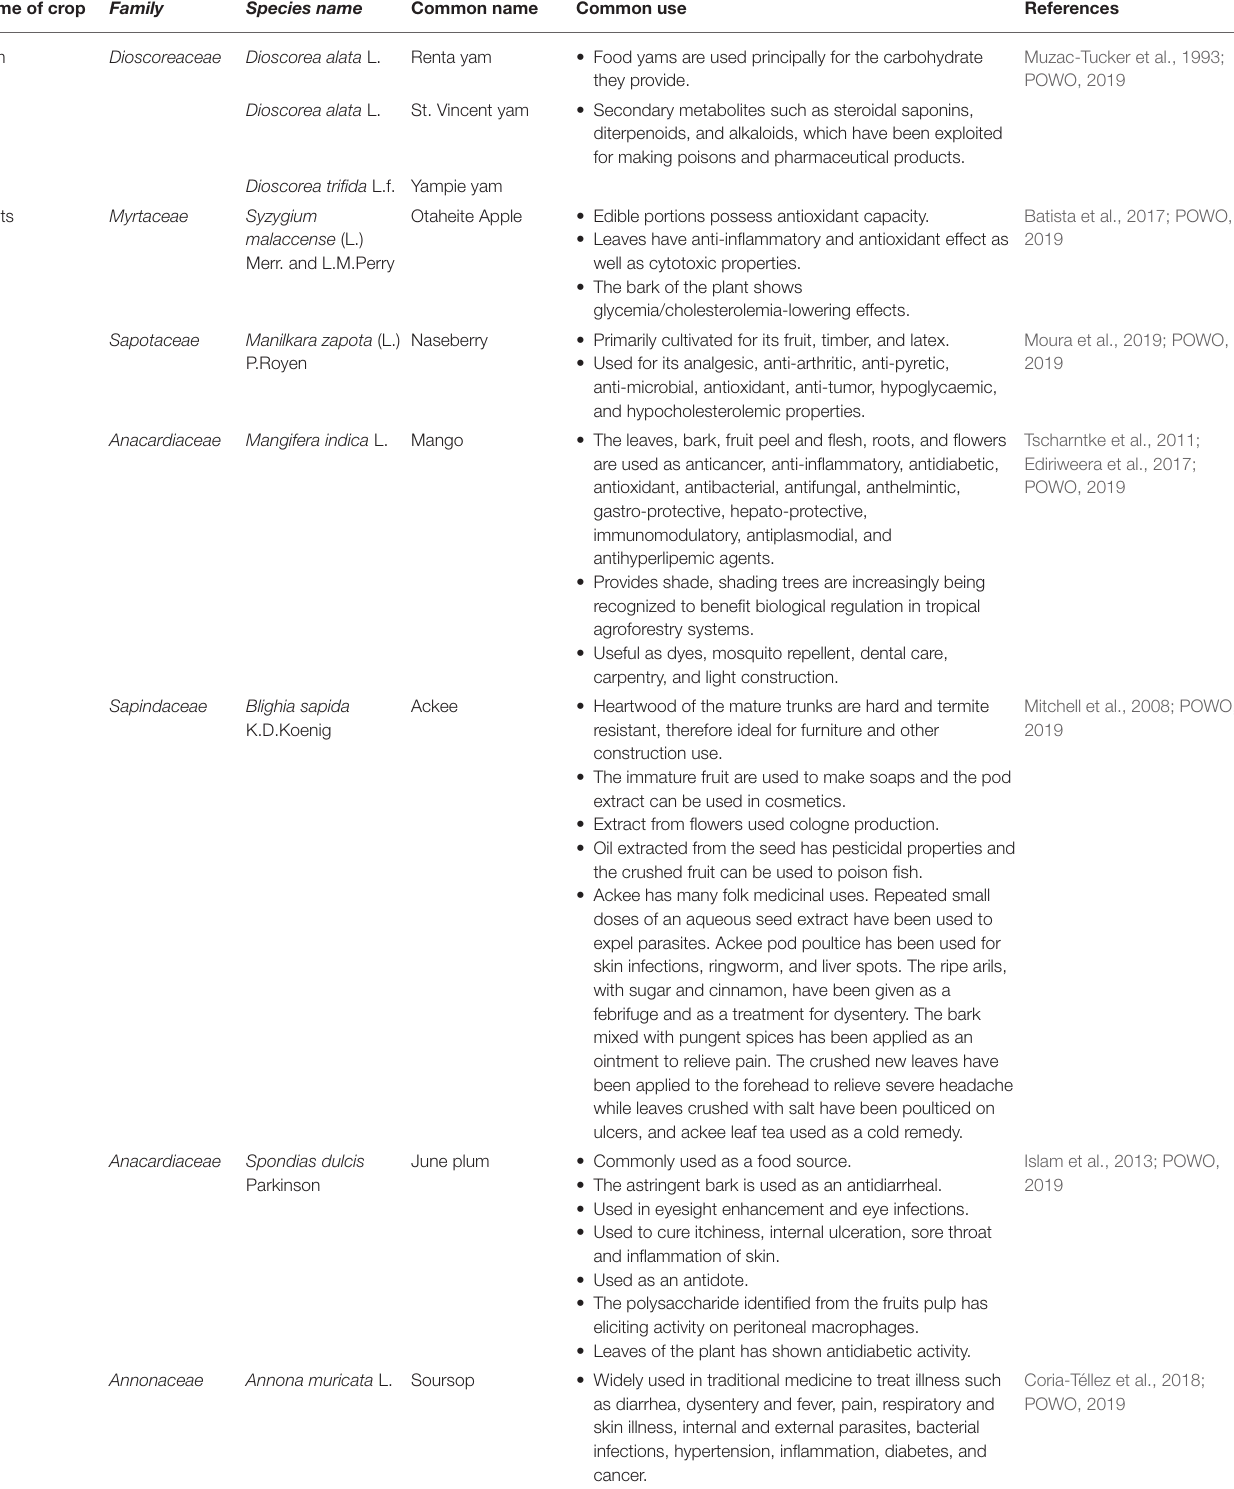
TABLE 1 | List of wild food and fruits and their common uses. Name of crop